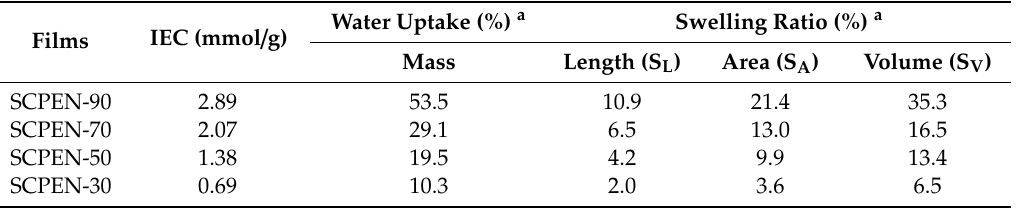
Table 3. The IEC, water uptake and swelling ratio of SCPEN